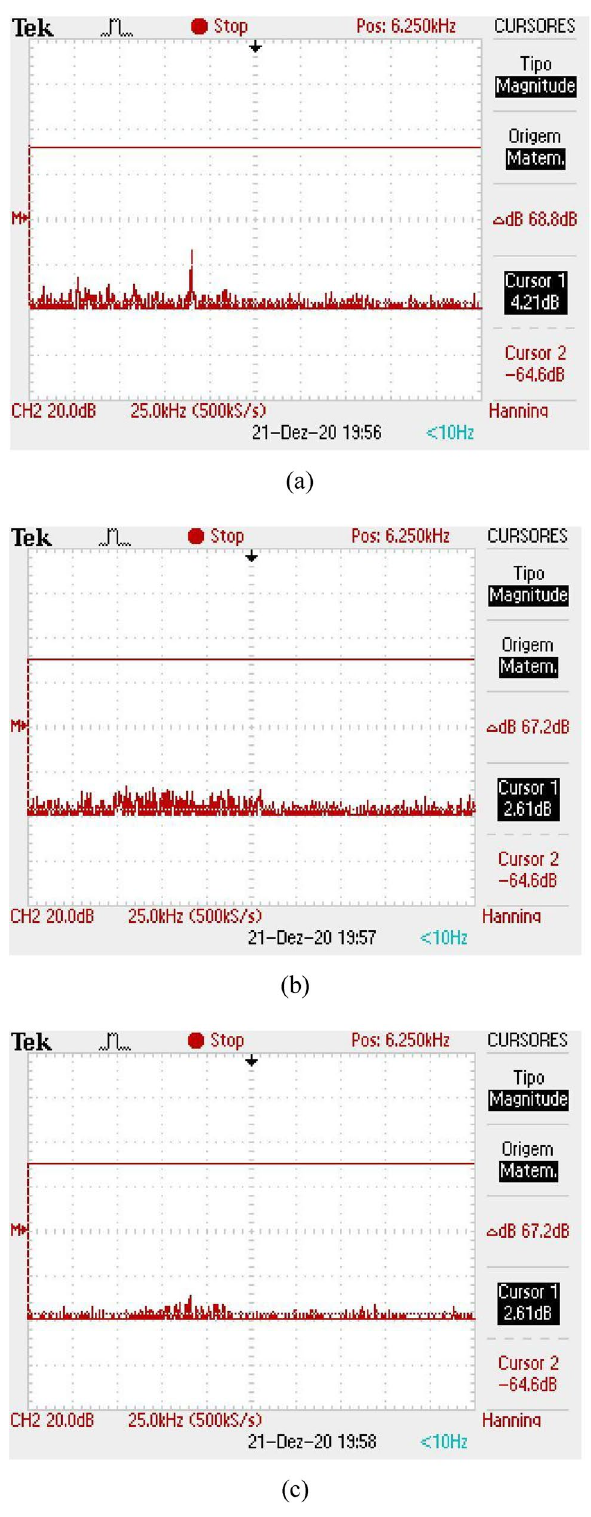
Figure 14. Reading of the noise level in frequency domain for the second version of the Osseus : ( a ) without finger, ( b ) with finger in the correct decision and ( c ) with the finger in the rotated